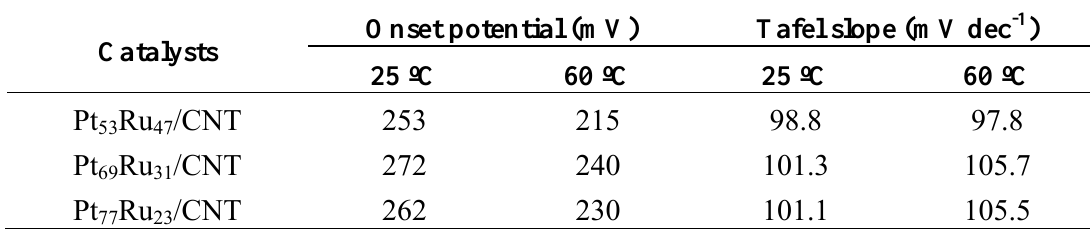
Table 1. Tafel slopes and onset potentials of the PtRu/CNT catalysts for methanol electro- oxidation at 25 ºC and 60 ºC.